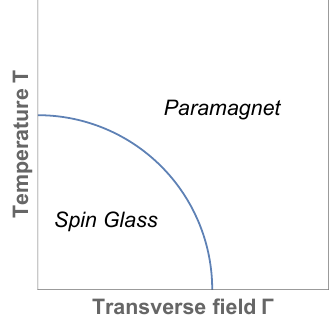
Figure 6. Schematic phase diagram of the quantum Sherrington-Kirkpatrick model. There is a spin glass phase at small external (cid:12)eld (cid:0) and small